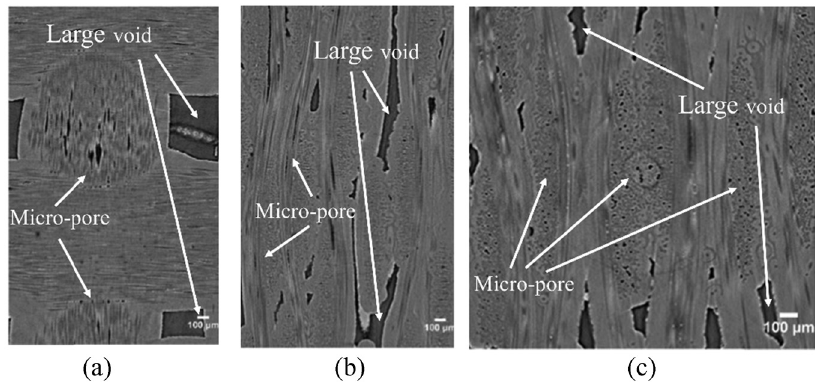
Figure 3: Distribution of initial holes on di ff erent slices: ( a ) XOY slice, ( b ) XOZ slice, and ( c ) YOZ slice [ 27 ]